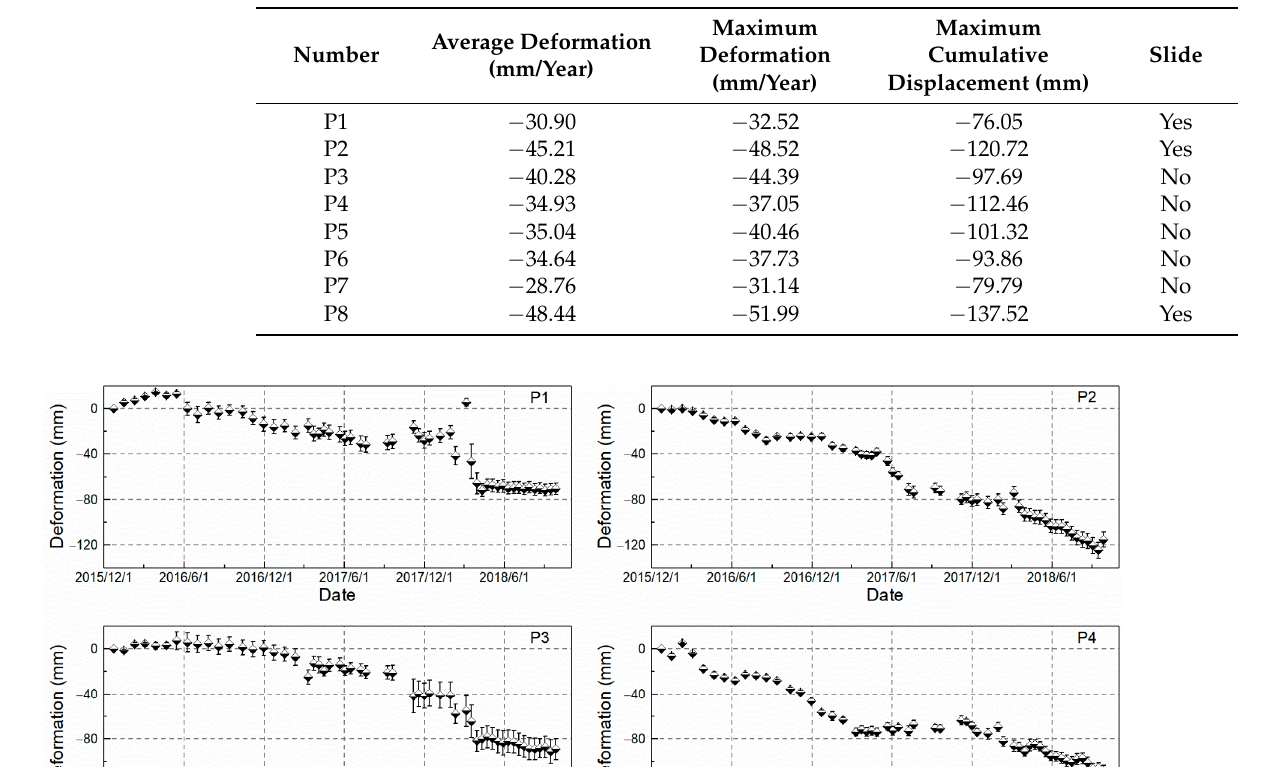
Table 2. Average deformation rate, maximum deformation rate, maximum cumulative deformation in the LOS direction and whether sliding occurred in all of the selected deformation regions.